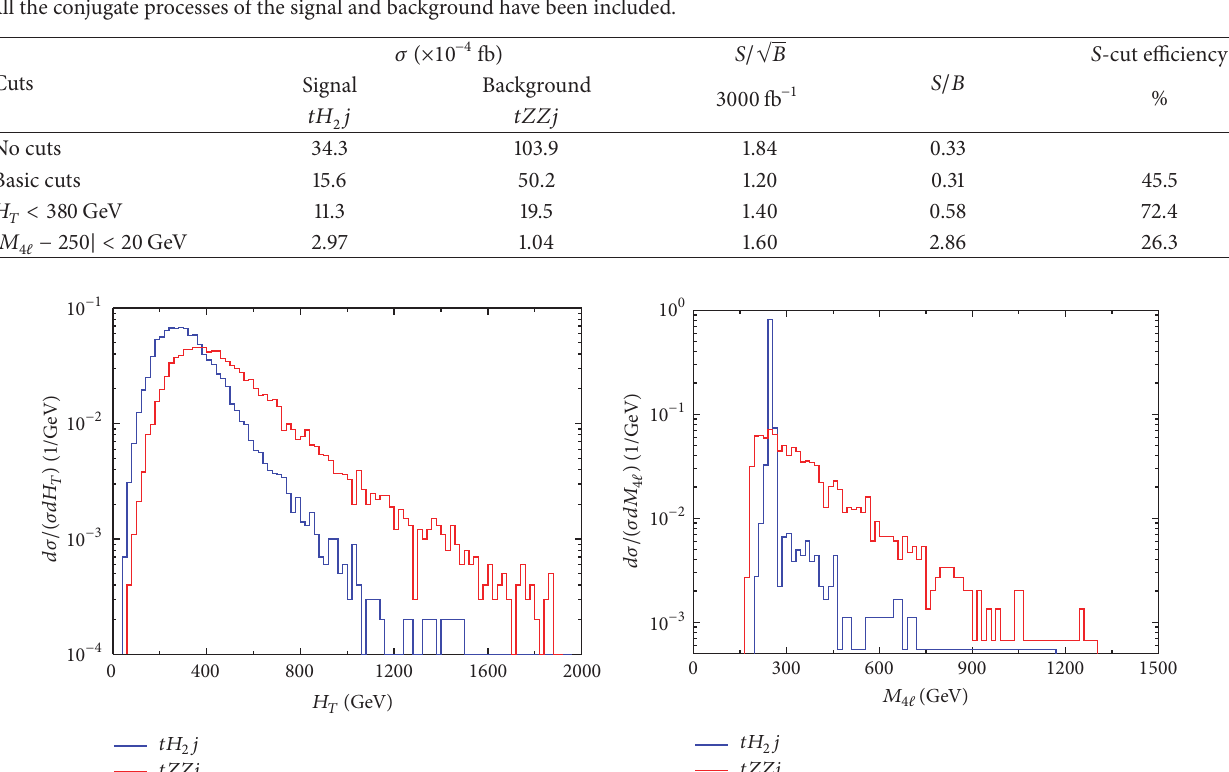
= 250 GeV, sin 𝛼 = 0.3 ). 2